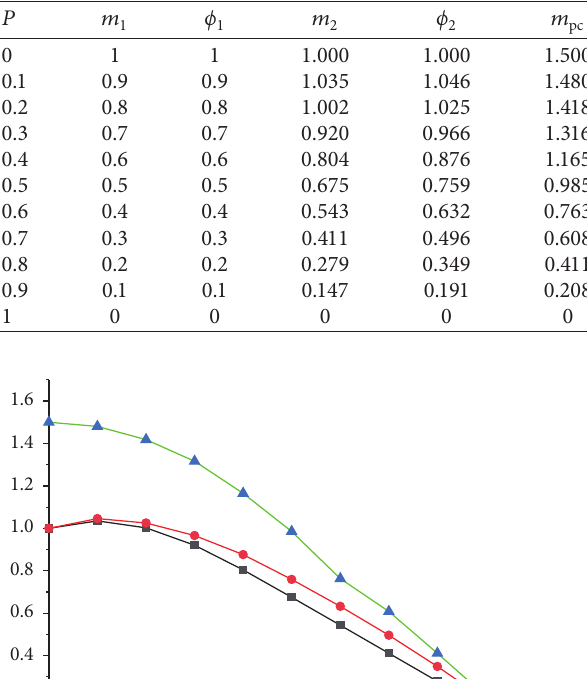
2 , ϕ 2 , (m) pc , and (p) of